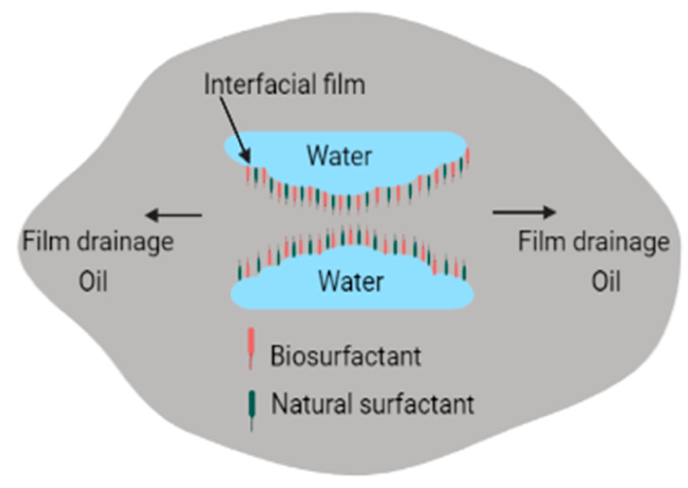
Figure 3. Demulsification of emulsions by biosurfactants.